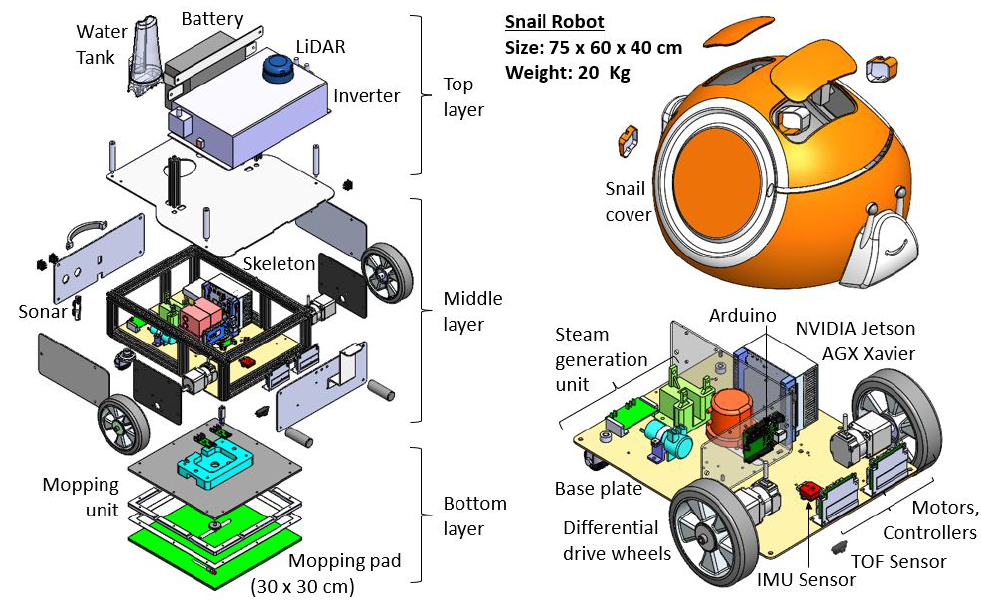
Figure 2. Snail robot’s CAD mechanical